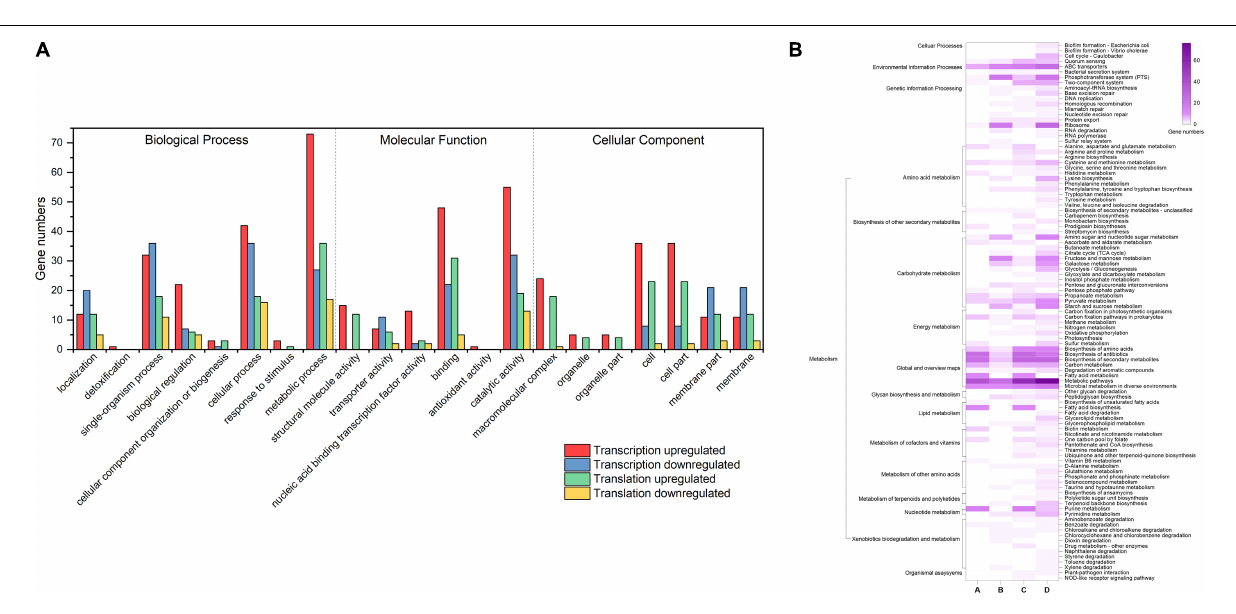
( | log 2 (fold change) | > 1) between CG and OS ( Figure 4 and Supplementary Table 2